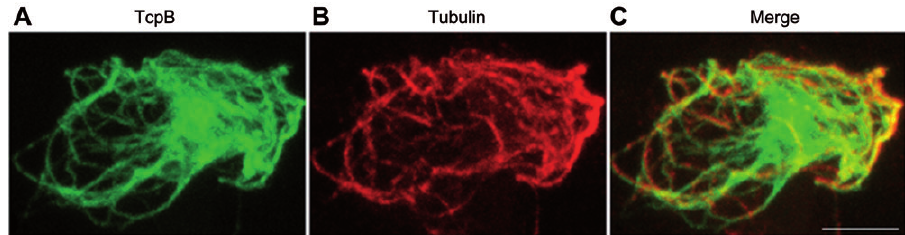
Figure 3 TcpB co-localizes with host microtubules. HEK-293 cells were transfected with pCMV-HA-TcpB plasmid and stained for HA-TcpB (A), tubulin (B), and merged (C). Scale bar, 5 µ